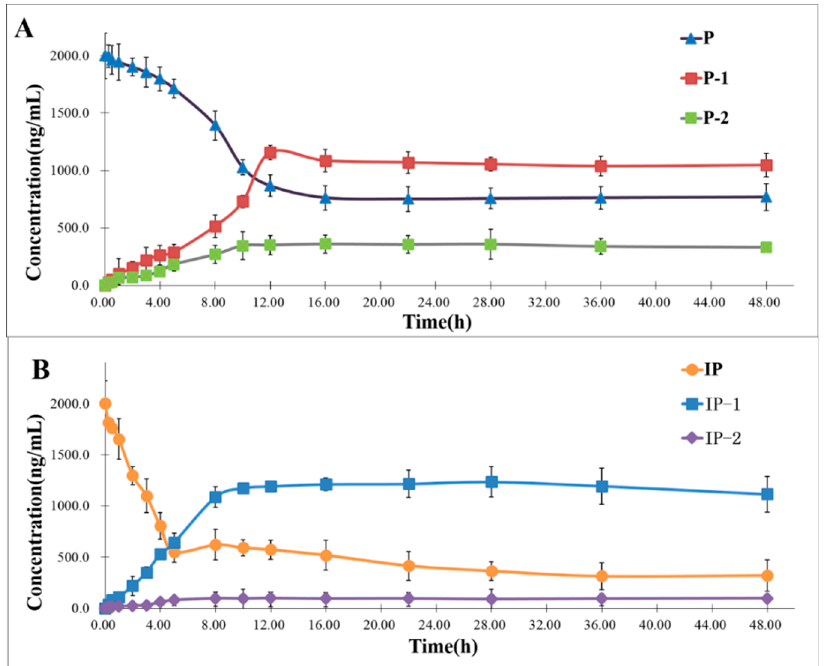
Figure 4. The time course of biotransformation of P ( A ) and IP ( B ) by active human intestinal flora ( n = 3, mean ± standard deviation (SD).